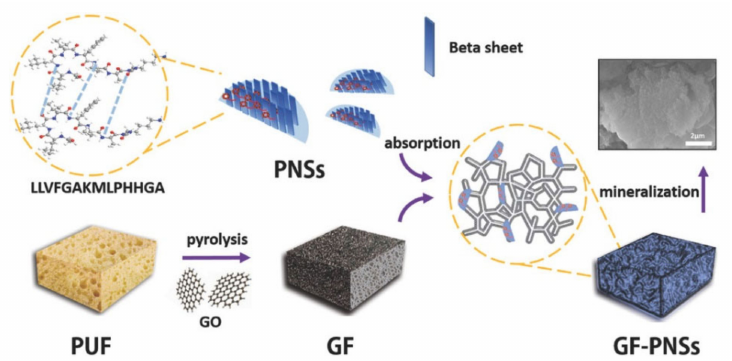
Figure 4. Schematic representation of peptide self-assembly into 2D nanosheets and biomimetic fabrication of 3D graphene foam–peptide nanosheets–hydroxyapatite minerals. Figure reproduced from [136].